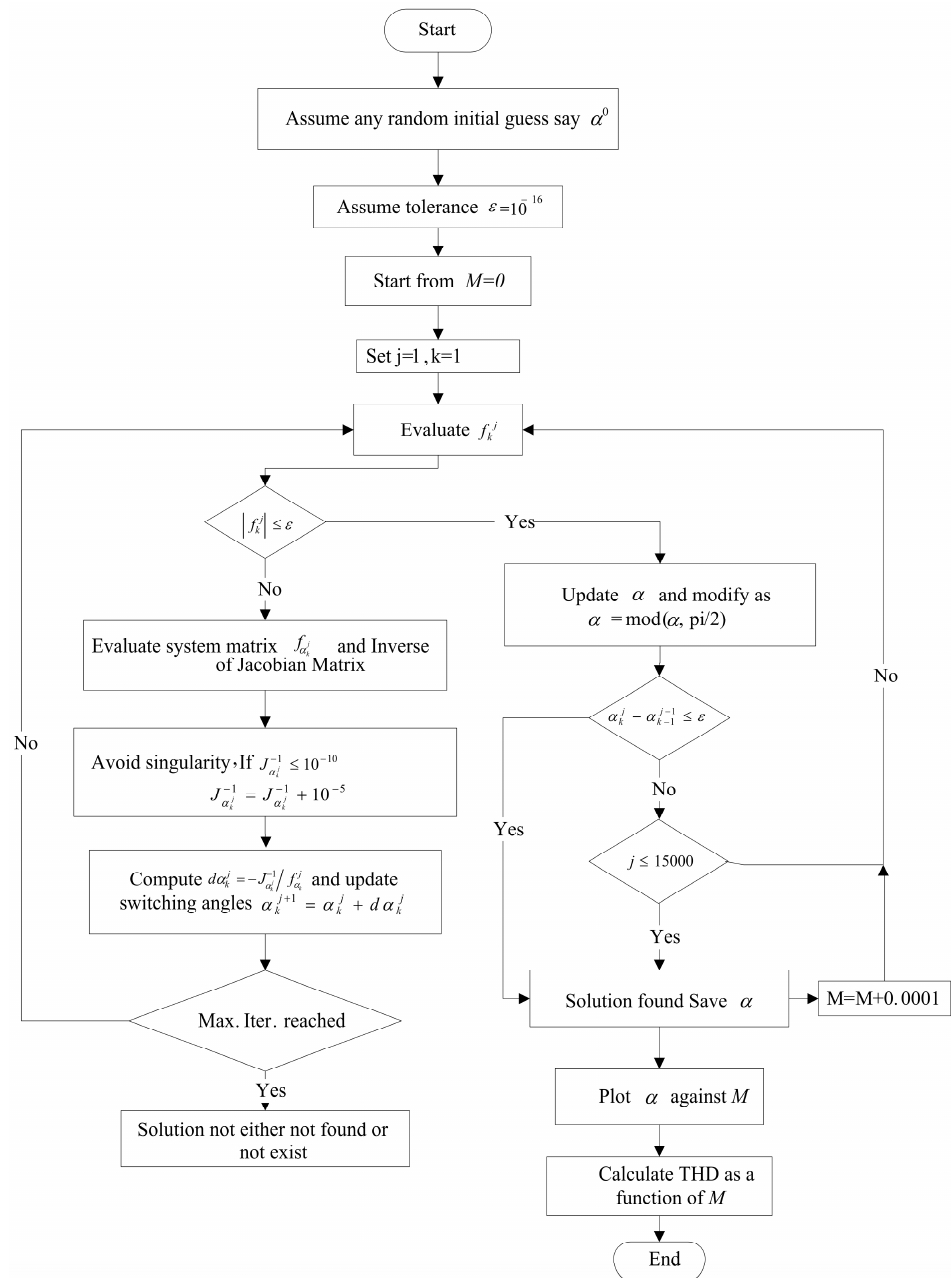
Figure 4. Flow chart of modified NR for solving SHE problem.